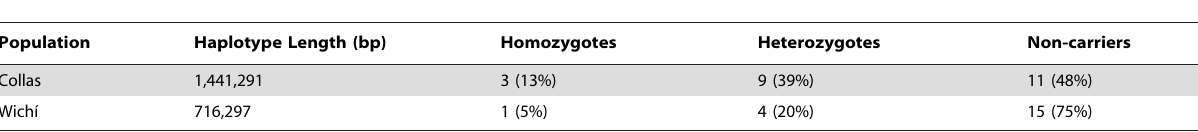
Table 5. VEGFB haplotype characterised by EHH . 0.3 in study